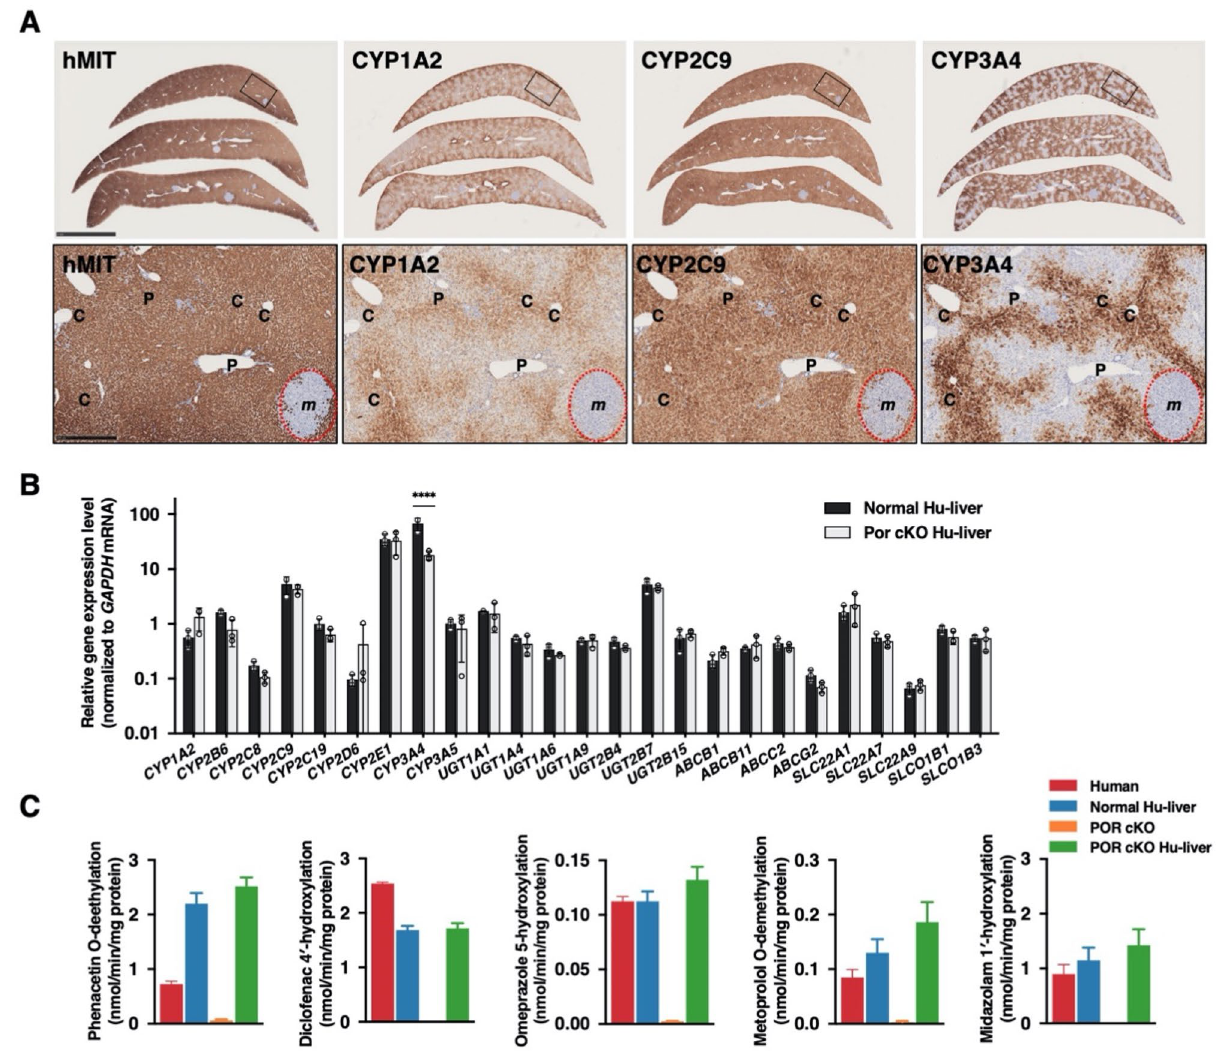
Figure 4. Characterization of POR cKO humanized liver mice. ( A ) Immunohistochemical staining of human Mitochondria (hMIT), CYP1A2, CYP2C9, and CYP3A4 proteins in liver tissue from POR cKO humanized liver mice. Rectangular area on top panel was enlarged in lower panel. Dotted circles indicate the region comprising mouse hepatocytes ( m ). P, portal tract, C, central vein. Scale bar, 5 mm ( top panel ) and 500 μm ( lower panel ). ( B ) Expression level of human pharmacokinetics-related genes in the liver from humanized liver TK-NOG (Normal Hu-liver) mice (n = 3) and POR cKO humanized liver (POR cKO Hu-liver) mice (n = 3) were measured via qRT-PCR. Data are presented as the mean ± SD. Statistically significant difference when compared with that in normal-Hu-liver mice; **** p < 0.0001. ( C ) Drug-metabolizing activity in liver microsomes from TK-NOG humanized liver mice (Normal Hu-liver), POR cKO mice, POR cKO humanized liver mice (POR cKO Hu-liver), and humans. Phenacetin (50 μM), diclofenac (40 μM), omeprazole (10 μM), metoprolol (5 μM), and midazolam (5 μM) were incubated with pooled liver microsomes (0.20 mg/mL) from normal Hu-liver mice (n = 4), POR cKO mice (n = 5), POR cKO Hu-liver mice (n = 4), and humans (n = 50) at 37 °C for 10–20 min. Data are presented as the mean ±